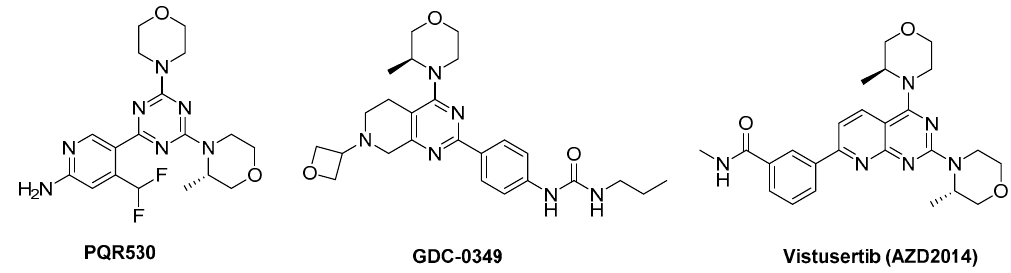
Figure 2. 3-Methylmorpholine containing pre-clinical kinase inhibitors.